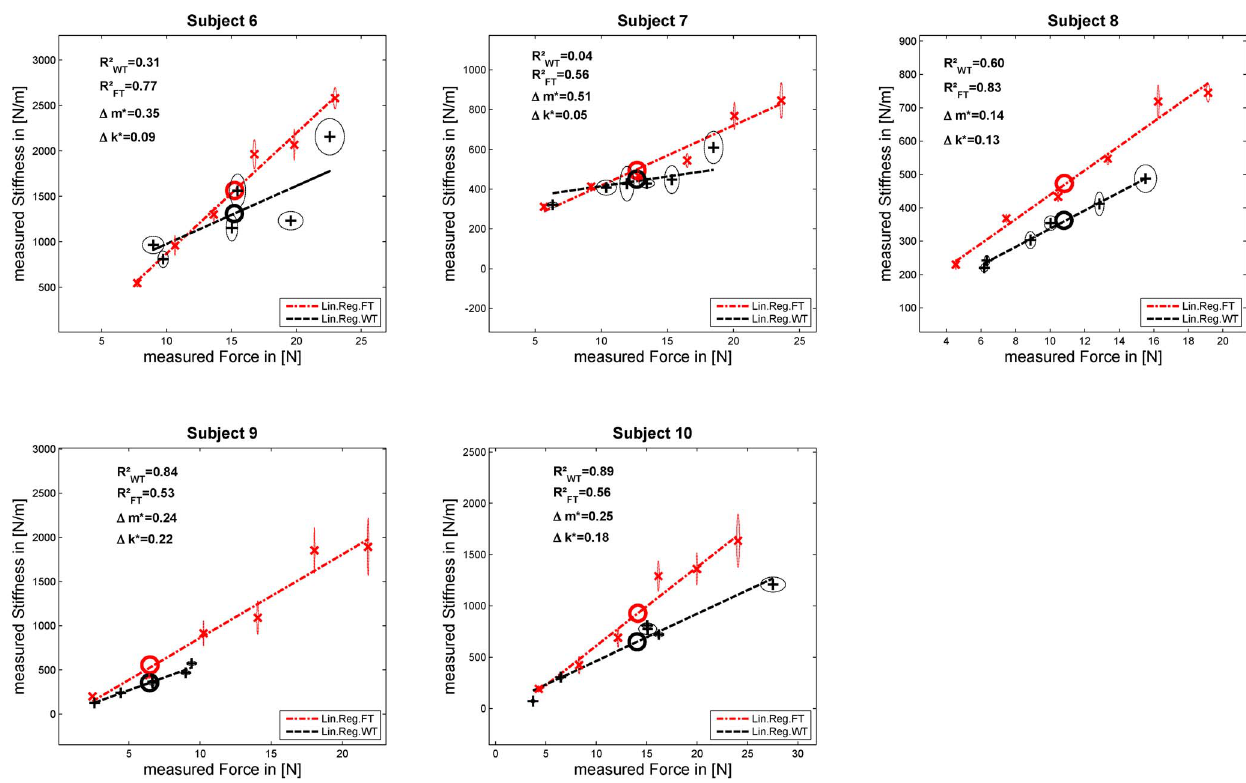
Figure 6. Results Experiment 2. Subjects doing the FT first without a cuff.